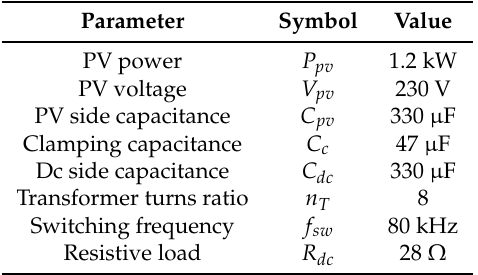
Table 1. Parameters of the step-down PPC with a full-bridge topology.